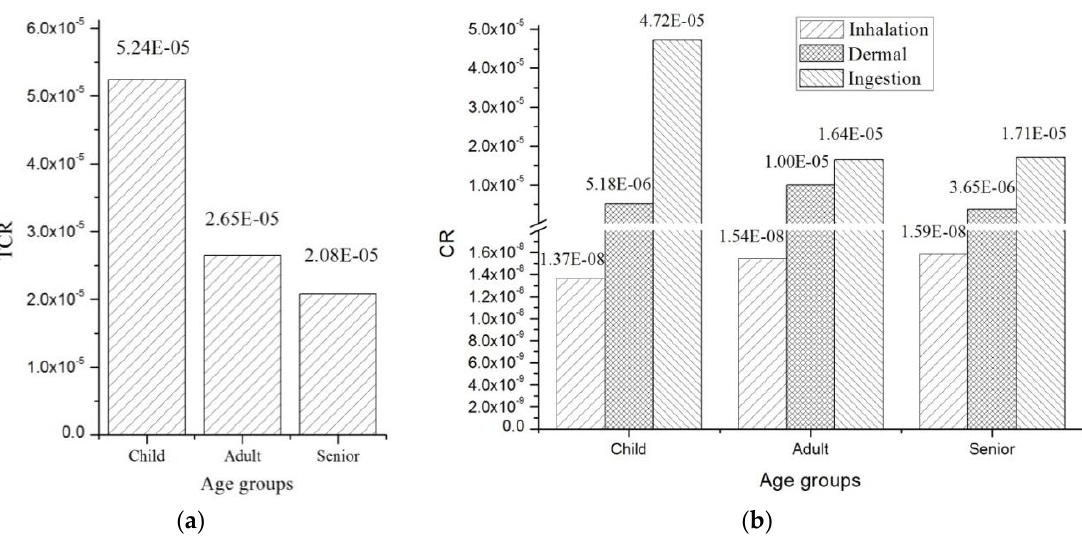
Figure 6. P robabilities of carcinogenic risk ( CRs) ( a ) and total carcinogens risks ( TCRs) ( b ) for Figure 6. Probabilities of carcinogenic risk (CRs) ( a ) and total carcinogens risks (TCRs) ( b ) for different different age groups under different exposure pathways. age groups under different exposure